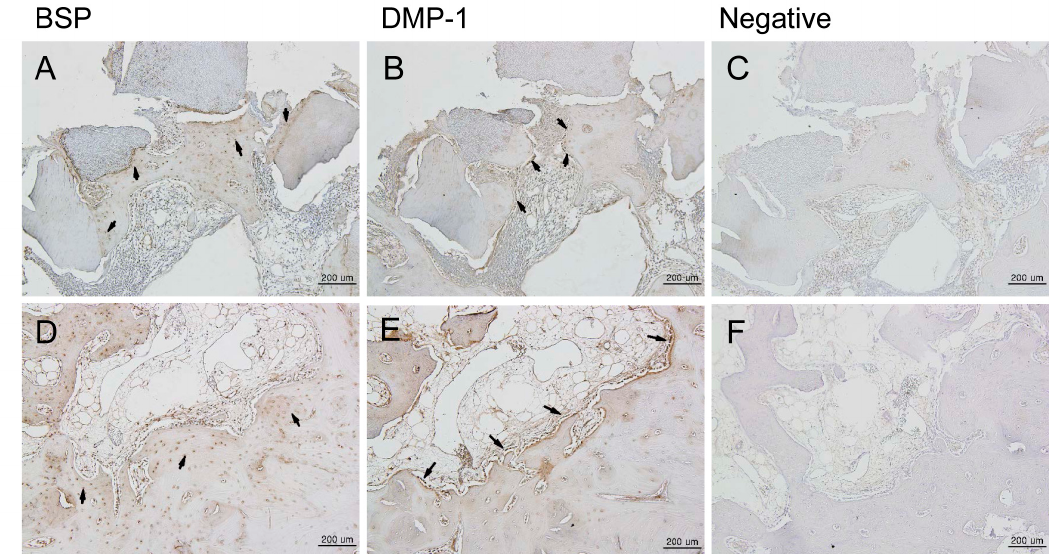
Figure 6. Immunohistochemical analysis of new bone formation at the bone defect area after four weeks (100×). BSP, DMP-1 proteins were expressed in the area of new bone formation after four weeks. ( A – C ) Experimental group (DDM fixed with rhBMP-2); ( D – F ) Control group (autogenous bone graft). New bone tissues were immunostained with anti-BSP ( A , D ) and anti-DMP-1 ( B , E ). Negative controls ( C , F ) included no primary antibody. ( A , D ) BSP expression was detected by immunohistochemistry in the area of new bone formation. BSP was expressed by osteocytes (arrows). ( B , E ) DMP-1 was expressed by osteoblasts (arrows). Scale bars: 200 μ m.